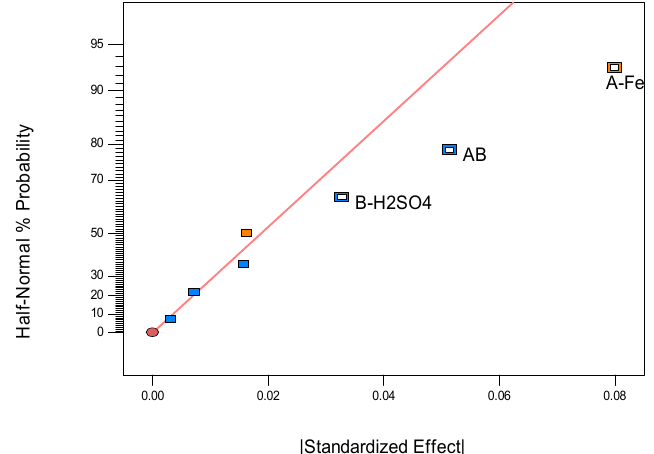
Figure 2. Half-normal probability plot for the factors and their interactions for “%Cu content of the precipitates”.